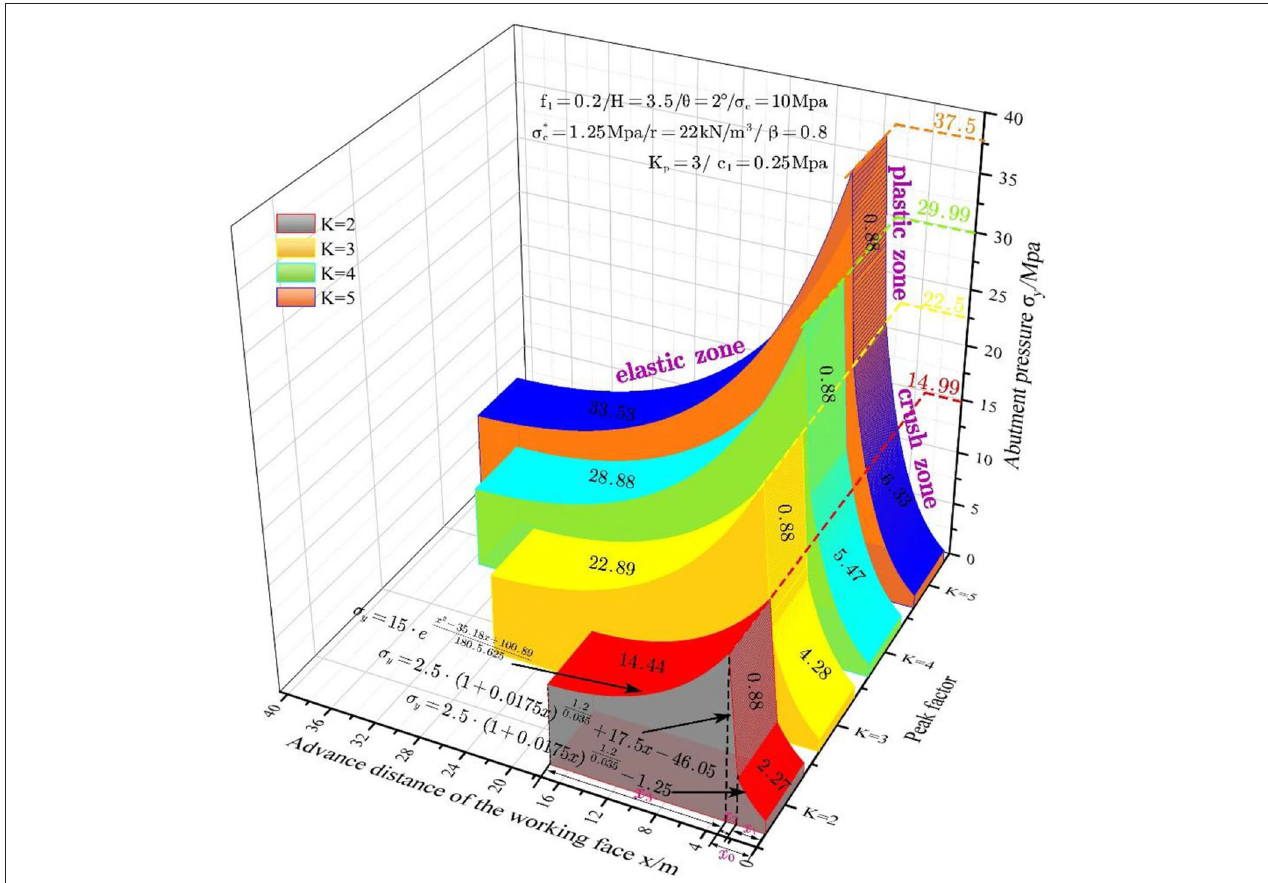
FIGURE 6 | Impacts of peak abutment pressure coefficient on abutment